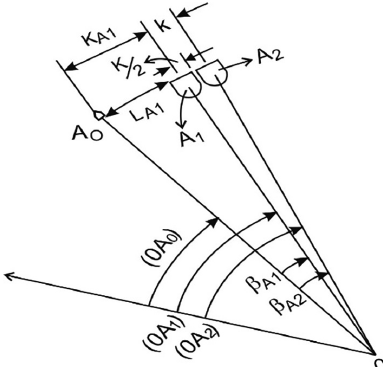
Figure 9. The bearing angles which are gone to the middle point of seat at the row of one piece curve The intermediate way portion (e.g. for the seats in H curve row L ) can be released together alleys on the H 3 curves of several rows placed behind of the stage in audi- torium (Figure 7). At the first part of the curve in the same row; consider of the left intermediate way portion, the bearing angles go to intermediate points of first, second and other seats from curve centre are calculated as seen in Section 3.6.1. At the second part of the same curve; the seat numbers are ordered from right to left. The first, sec- ond and i. seat midpoint of specified curve, as arc length from auditorium right side wall ( L = L = to be side H 2 H 1 way portion), similar to Equation (27), for the placed seat midpoints at the first part of related curve: Figure 8. Locating of two intermediate way portions which are formed at the same curve in every row in Auditorium The angles are seen these calculated arcs from centre